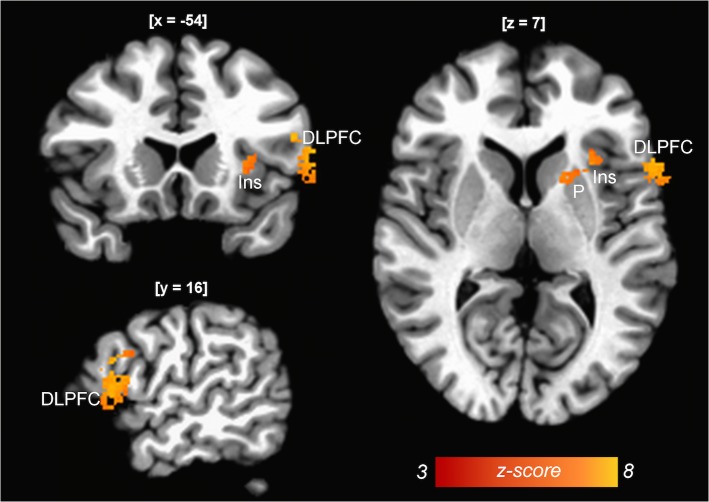
Seed based fMRI analysis: Comparison of resting state functional connectivity before and after neurofeedback training (p(FEW) < 0.05).After neurofeedback, increased functional connectivity was detected between the left Brodman Area 46 and different cortical and subcortical brain regions, including the dorsolateral prefrontal cortex (DLPFC), the insula (Ins) and the putamen (P) of the ipsilateral hemisphere. Connectivity patterns are superimposed on the TT N27-template. Images are displayed in the radiological convention (coordinates in Talairach space are given in parenthesis).